Question: In a single sentence, describe what this figure presents.
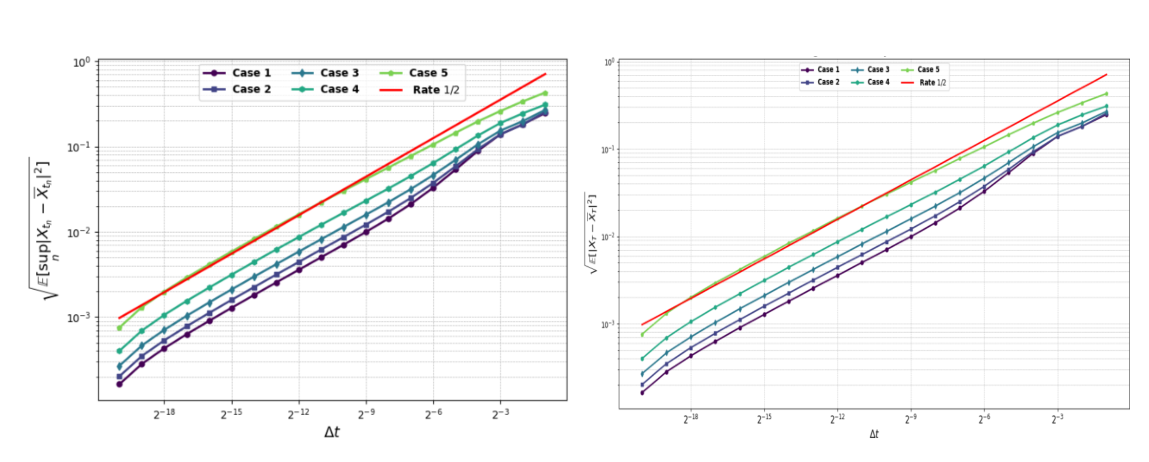
Answer: Strong approximation error for the Exp-EM scheme applied to (4.1), with Cases 1 to 5 (in log-log scale), E1/2  sup0≤t≤T |Xt −Xt|2 (left) and E1/2  |XT −XT |2 (right). The strong error is compared with the reference slope of order 1/2 (in red).